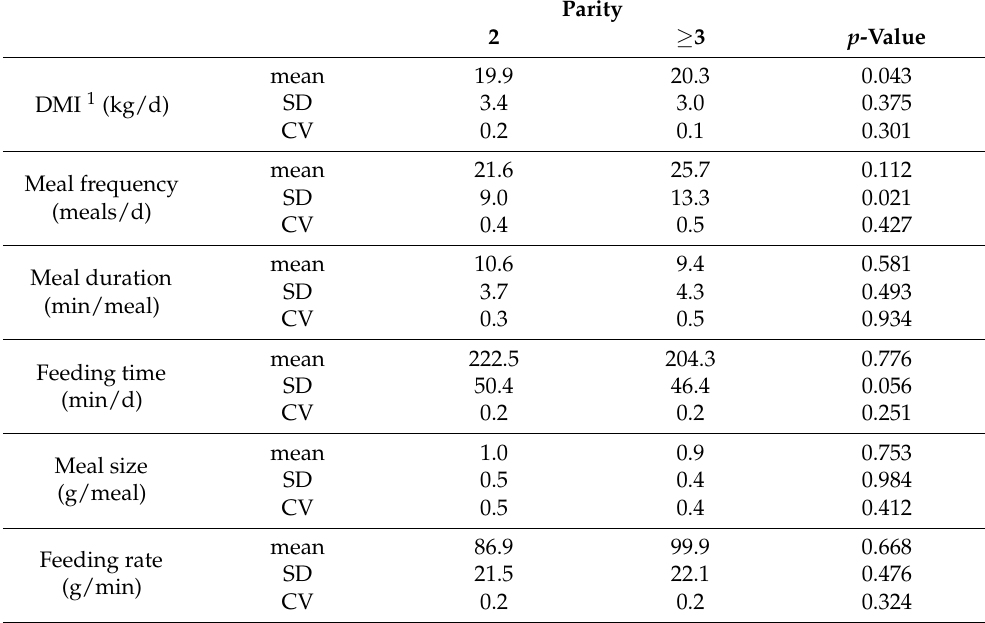
Table 4. Mean, SD and CV values of dry matter intake (DMI) and variable of intake behavior of early lactating dairy cows grouped in second and greater than or equal to third lactating dairy